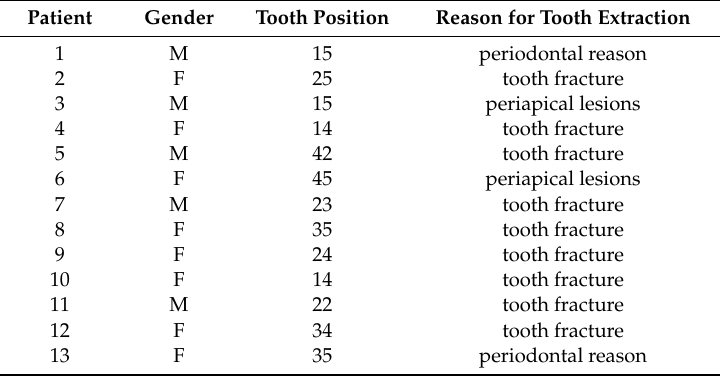
Table 1. Demographic data of the population enrolled in the study.